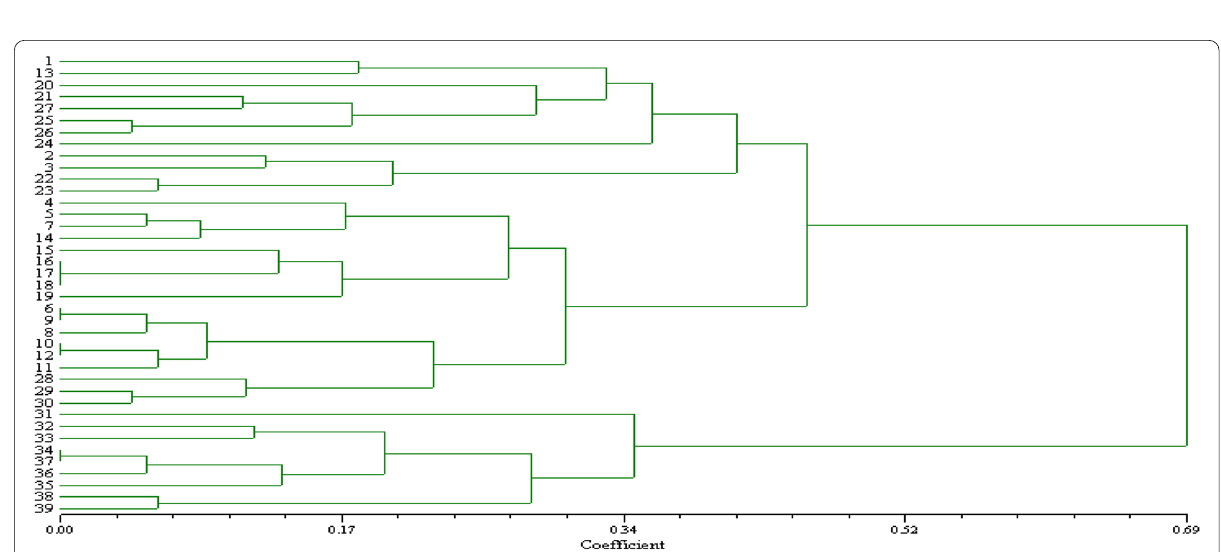
Fig. 4 Dendrogram of 39 tomato landraces generated by UPGMA cluster analysis of the dissimilarity values based on Nei (1972)